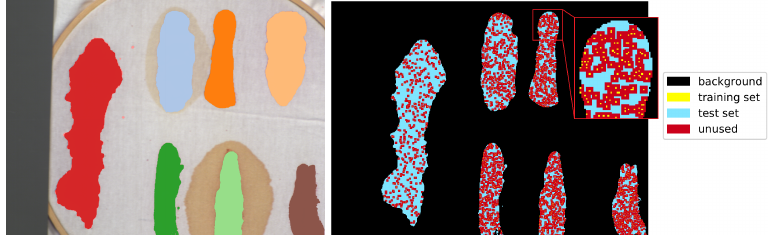
Figure 9. An example of the train and test set selection for the F(1) image. The left panel presents a RGB visualization with superimposed ground truth class labels. The right panel presents selected training (5% · n s , where n s is the number of pixels of the least numerous class) and test examples. Pixels within 2-pixels neighbourhood of every training point are not used for testing to avoid non-empty intersection between training and test sets for networks that process patches of